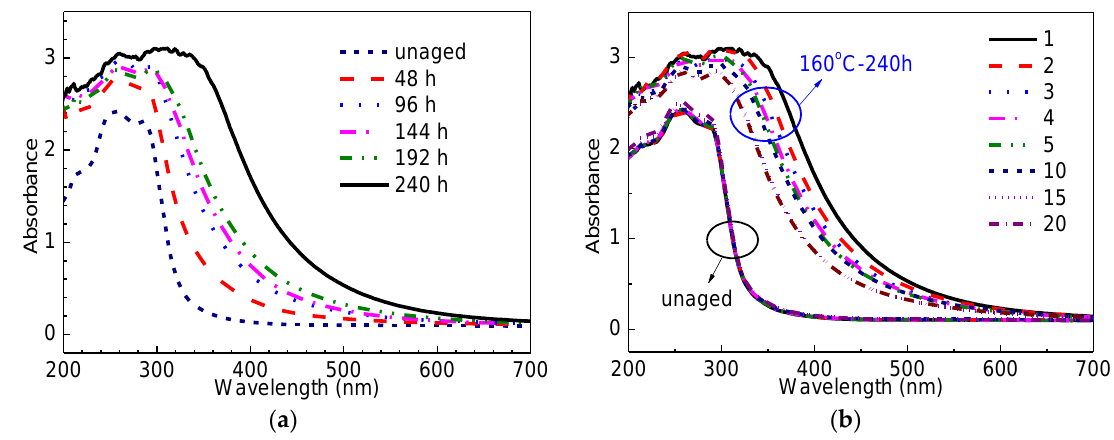
Figure 3. ( a ) UV–Vis absorption spectra of the No.1 sample as a function of ageing time; ( b ) UV–Vis absorption spectra of unaged and aged for 240 h XLPE samples at different positions.